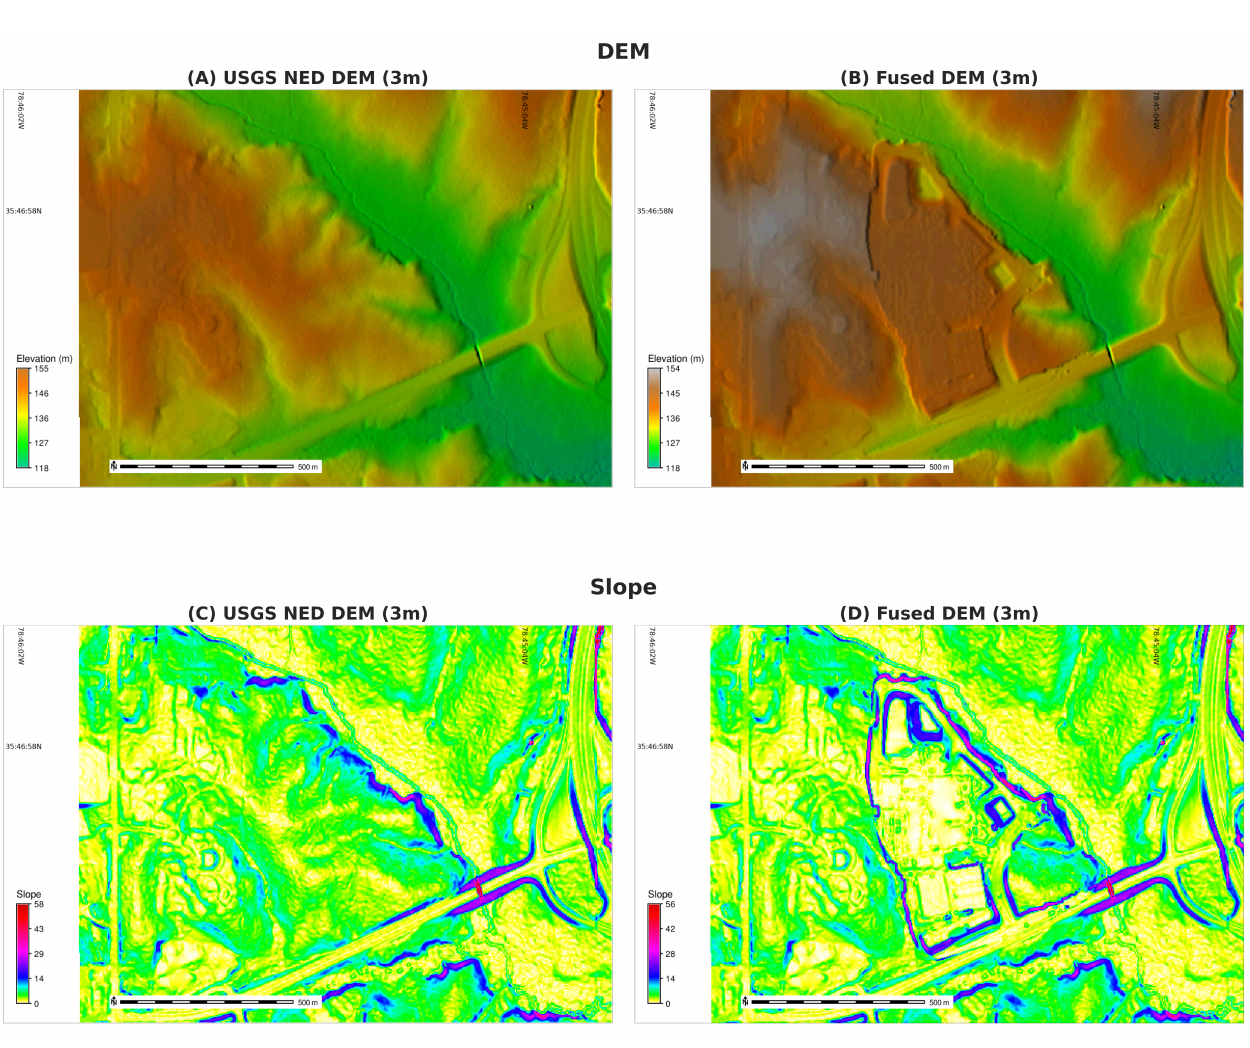
Figure 14. Elevation and slope maps at 3 m resolution: ( A ) USGS NED DEM, ( B ) Fused DEM, ( C ) USGS NED DEM slope, and ( D ) Fused DEM